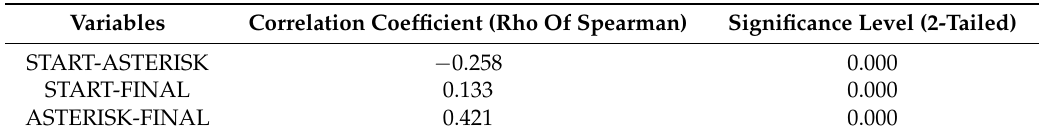
Table 2. Global correlations between